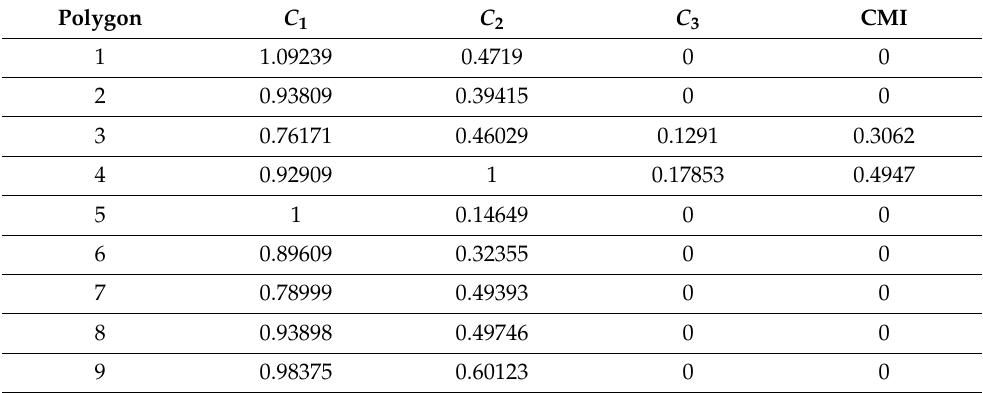
Table A4. Evaluation of components of (Equation (1)) that required determination for each of the 9 actuation polygons by defining the value of CMI for n 1 × 0.2; n 2 × 0.4; y, n 3 × 0.4, in case of